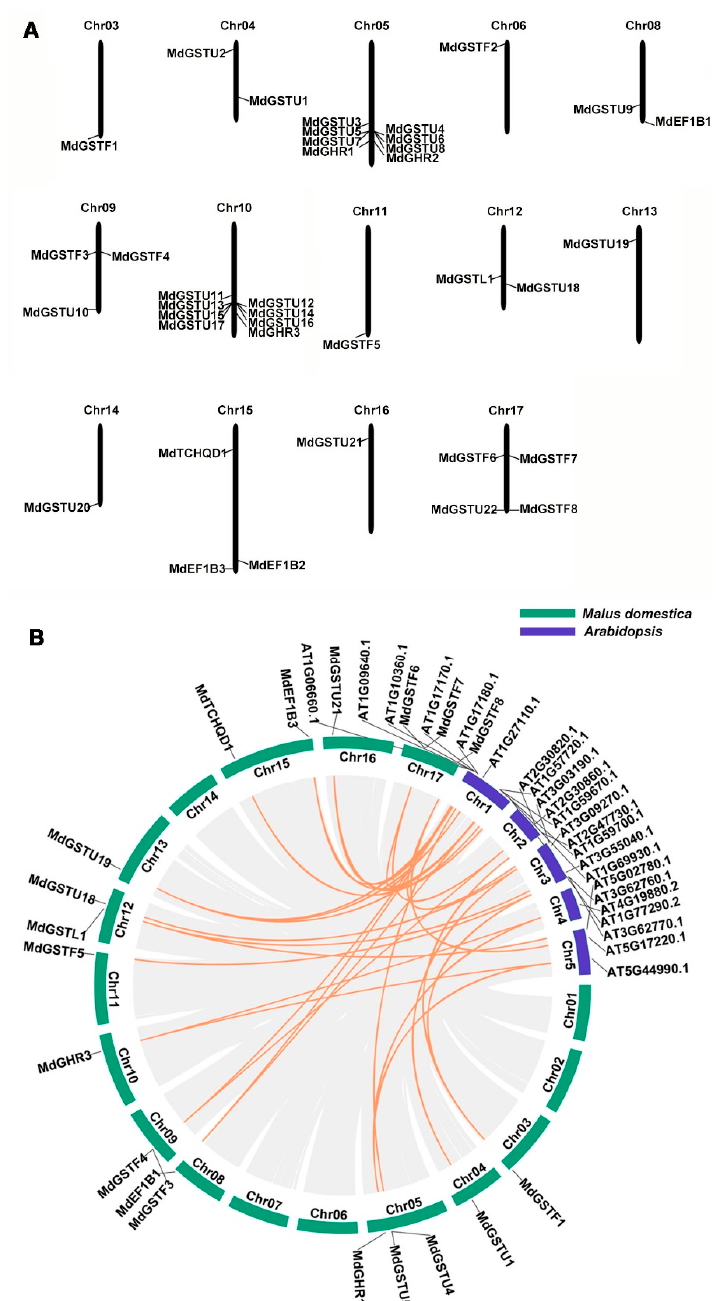
Figure 2. Chromosomal locations and collinearity analysis of the MdGSTs . ( A ) Chromosomal locations of the 38 MdGSTs in apple, which are based on the physical positions (Mb) of genes from the apple HFTH1 genome. MdGSTs were located on 14 of the 17 apple chromosomes. The chromosome number is shown at the top of each chromosome. ( B ) Collinearity analysis of GSTs among apple and Arabidopsis chromosomes.